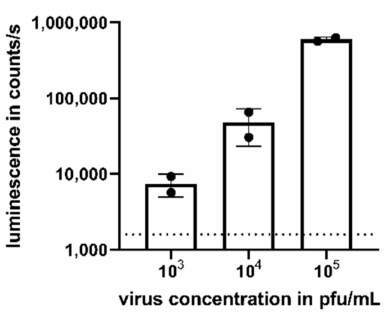
Figure 3. Detection of CHIKV viremia in human serum. Human serum was spiked with CHIKV with a concentration ranging from 10 3 to 10 5 pfu/mL prior to the addition to TR-RNA-luc-transfected HEK 293T cells. After 16 h, luciferase signals were detected as counts/s and compared to unin- fected cells (dotted line). Depicted values are mean values ± SD of two independent experiments performed in